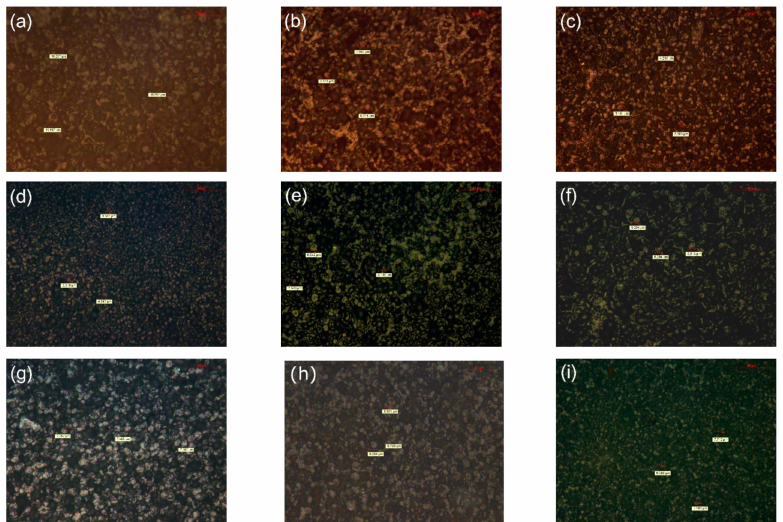
Figure 3. PLM results of polypropylene nanocomposites with different amounts of NKT90/P90. ( a ) PP; ( b ) 0.5NKT90; ( c ) 1.0NKT90; ( d ) 1.5NKT90; ( e ) 2.0NKT90; ( f ) 0.5P90; ( g ) 1.0P90; ( h ) 1.5P90; ( i ) 2.0P90.